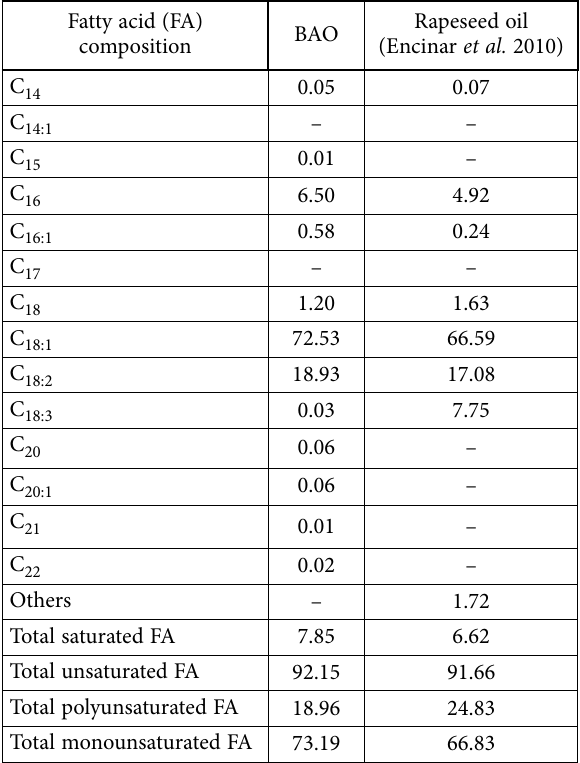
Table 2. Fatty acid composition of BAO compared to